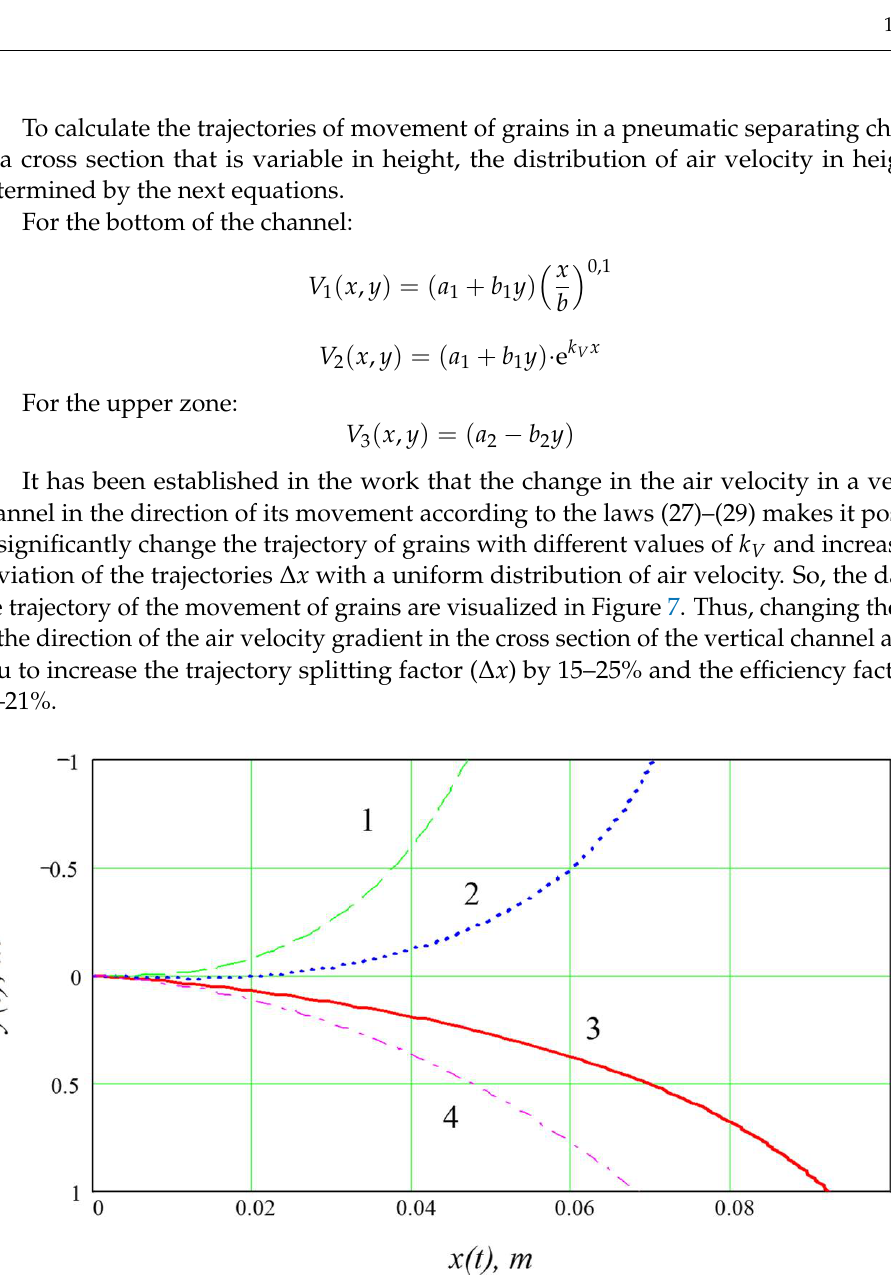
( b ) Figure 8. Distribution of air flow velocity and pressure in a vertical channel of variable cross section at ( a )— (cid:1848) (cid:3017) = 5 m/s; ( b )— (cid:1848) (cid:3017) = 9 m/s. 4. Conclusions 1. Improving the efficiency of fractionation of grain mixtures in air flows and reducing energy consumption is ensured by using an unevenly directed field of air flow velocities and changing their intensity over time. So, changing the sign of the direction of the air velocity gradient in the cross section of the vertical channel makes it possible to increase the trajectory splitting coefficient by 15–25% and the efficiency coefficient by 17– 21%. 2. The developed mathematical model of the dynamics of grain movement in an uneven air flow, taking into account the action of transverse forces such as Zhukovsky and Magnus, made it possible to evaluate the possibility of separating components during the downward countercurrent movement of grains in a vertical channel. The influence of the action of individual forces and the separation mode on the magnitude of the branching of the trajectories, which determines the efficiency of separation of the grain mixture, has been established.